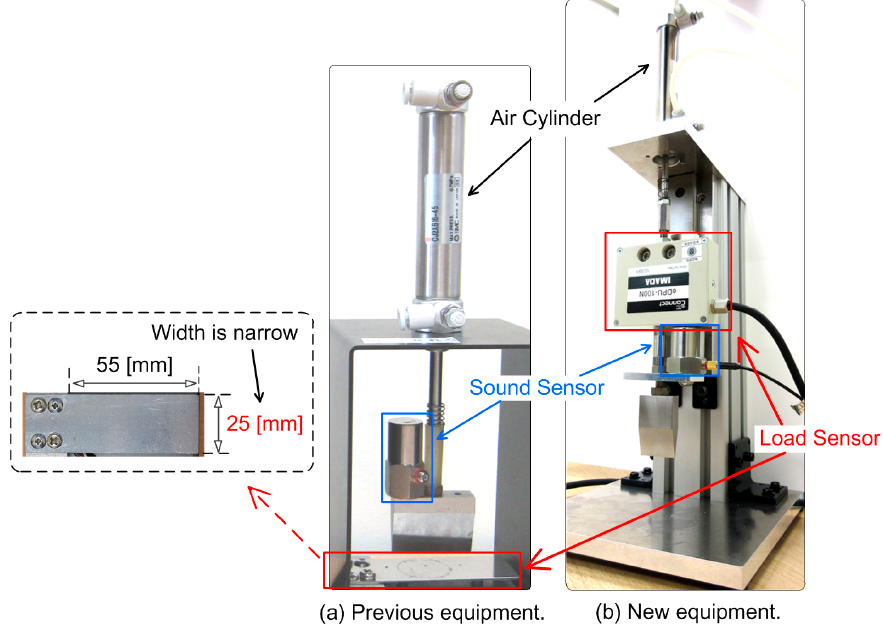
Figure 1. Equipment for food texture evaluation: ( a ) Previous equipment. The plate of the load sensor is small; ( b ) proposed equipment. The load sensor is above the probe, thereby accommodating differently sized food